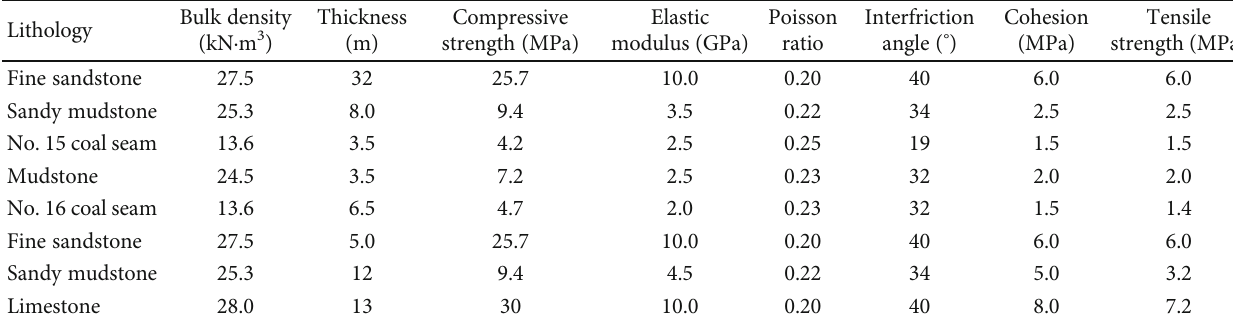
Table 1: The physical and mechanical properties of roadway surrounding